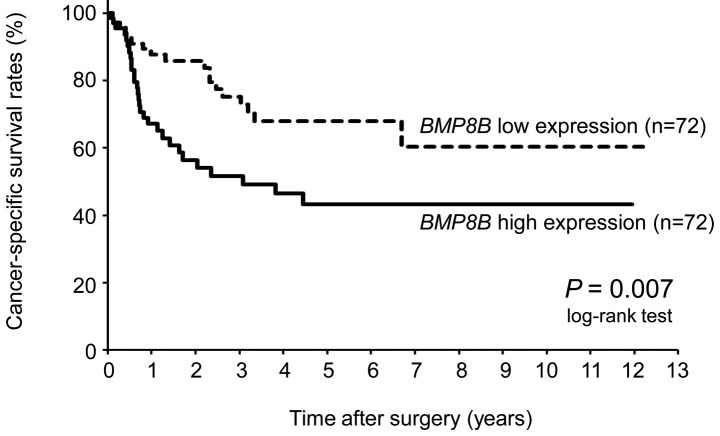
Kaplan-Meier survival analysis of cancer-specific survival in 144 gastric cancer patients comparing the high BMP8B expression group and the low BMP8B expression group using the log-rank test.